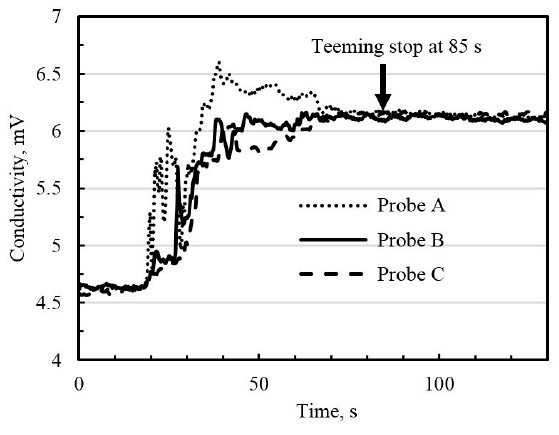
Figure 8. Typical tracer homogeneous curves in different probes.